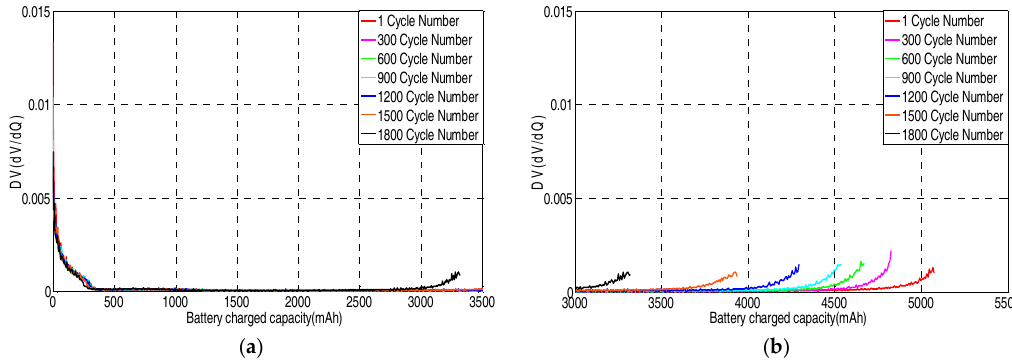
Figure 6. ( a ) Differential voltage during the initial charging process; and ( b ) differential voltage at the end of the charging process.